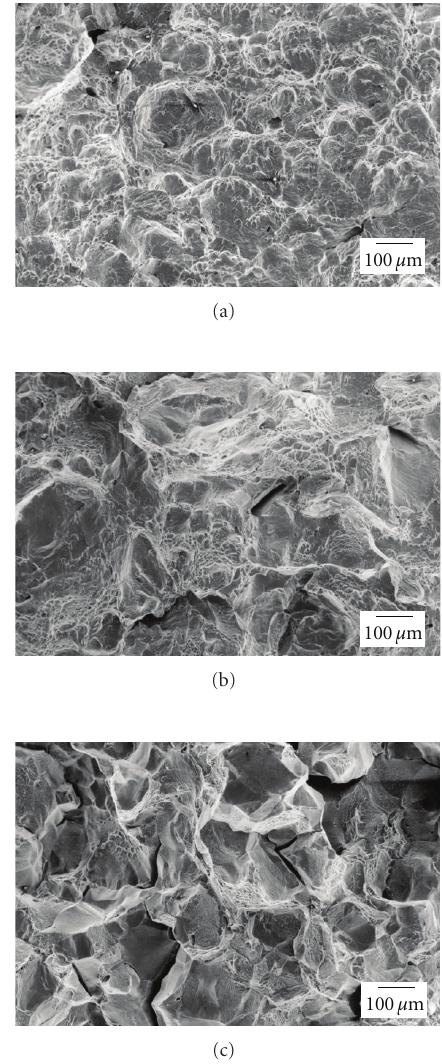
Figure 10: SEM fractographs of CVN impact test specimens for the JN1 steel (a) solution treated and aged at 1173 K for (b) 10 and (c) 1000 min.